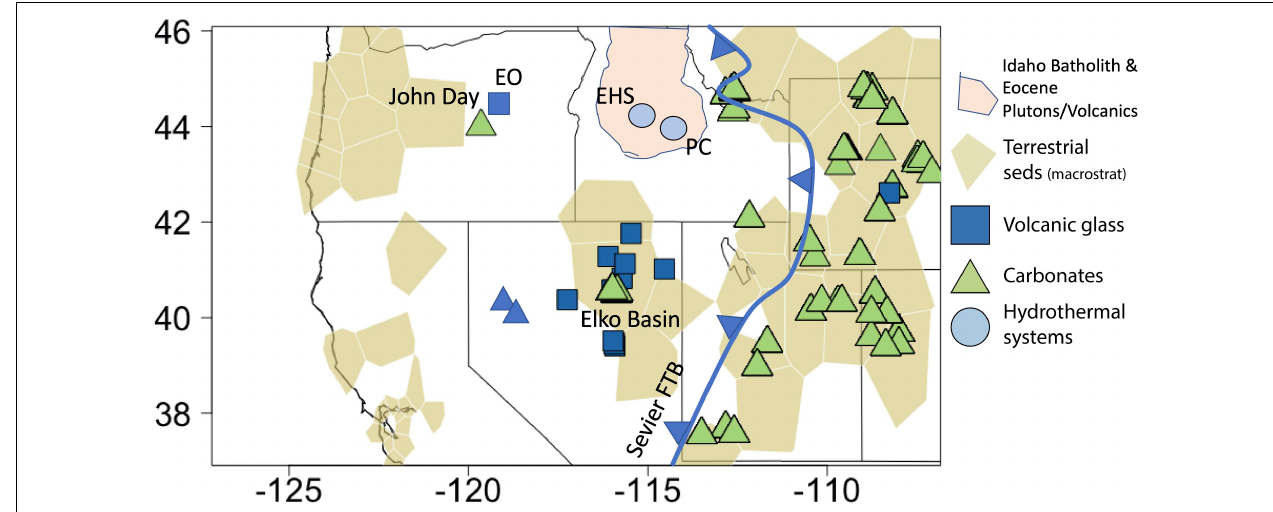
FIGURE 1 | Map of the Idaho batholith and Eocene plutons and volcanics and surrounding Eocene basins. Shown are the sites sampled for paleoaltimetry analysis for the Eocene. The triple oxygen isotope study of the Eocene hydrothermal system (Chamberlain et al., 2020) is given as the dot (EHS), the Pioneer core complex (PC; from McFadden et al., 2015), and the Early Oligocene volcanic glass in Blue Mountains (EO; from Bershaw et al., 2019). Shown is the eastern margin of the Sevier fold and thrust belt (Sevier